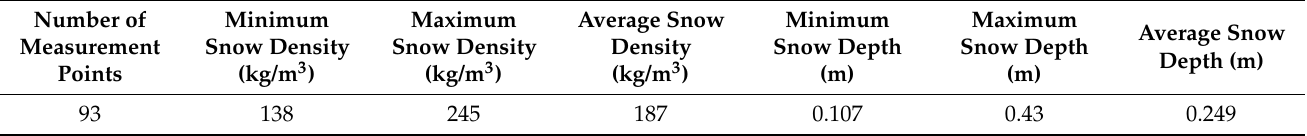
Table 2. General situation of snow cover parameters at measurement